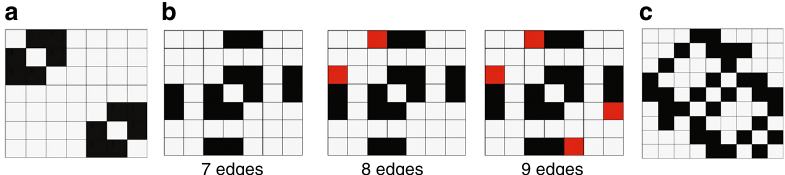
Fig. 6 Illustration of simple simulated networks. Adjacency matrices in which black at coordinate ( i, j ) indicates an edge from node i to node j . a Seven node network at time t . b Seven node networks at time t + 1, with 7, 8, and 9 edges. Red indicates edges added to the leftmost network. c Nine node